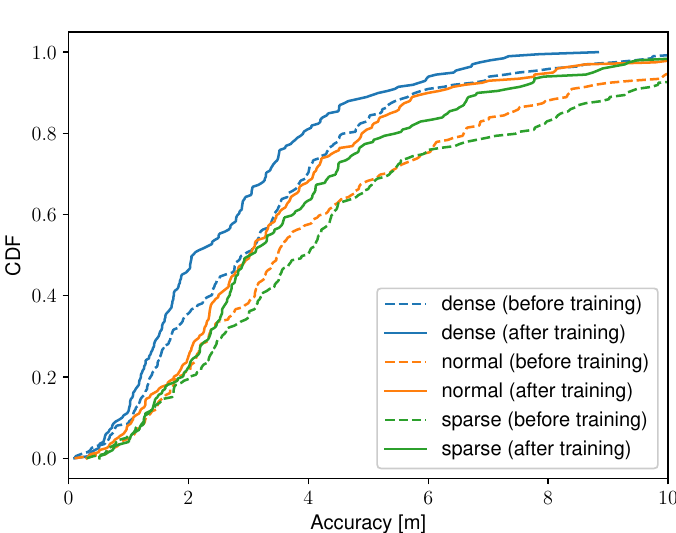
Figure 8. Cumulative distribution function of the localization accuracy before (dashed line) and after training (solid line), for the three access point configurations and the WHIPP path loss